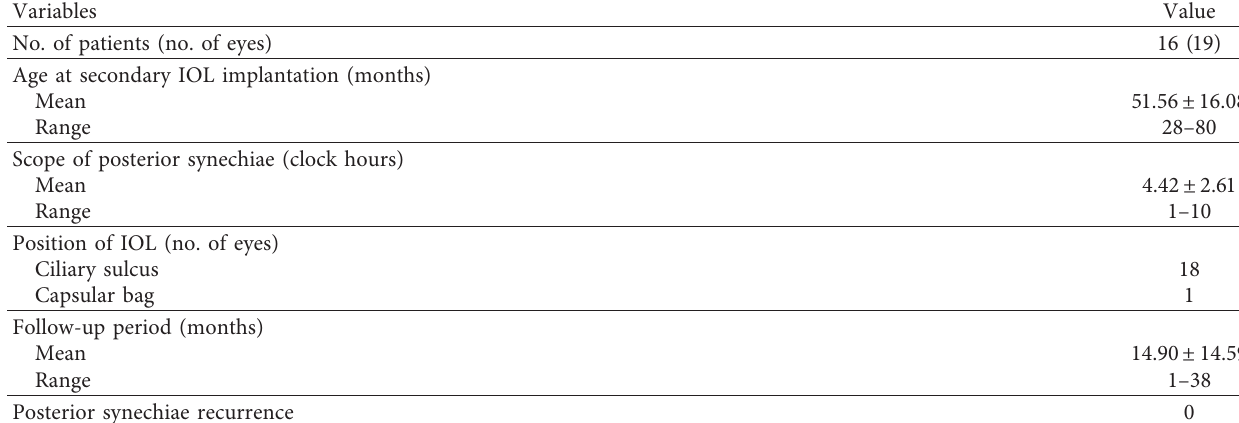
Table 1: Demographic and clinical details of the patients.